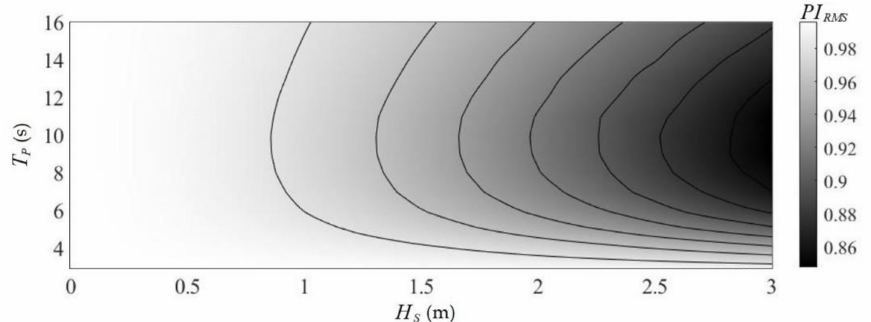
Figure 12. Contour map of the normalized performance index as a function of the prevailing sea state (significant wave height H S and peak period T P